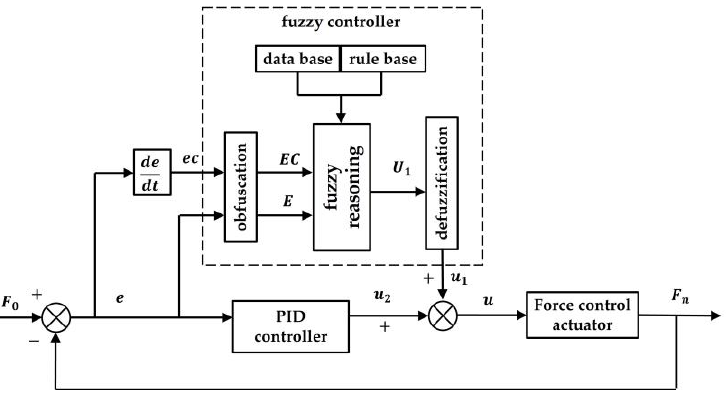
Figure 8. Fuzzy PID controller framework diagram.